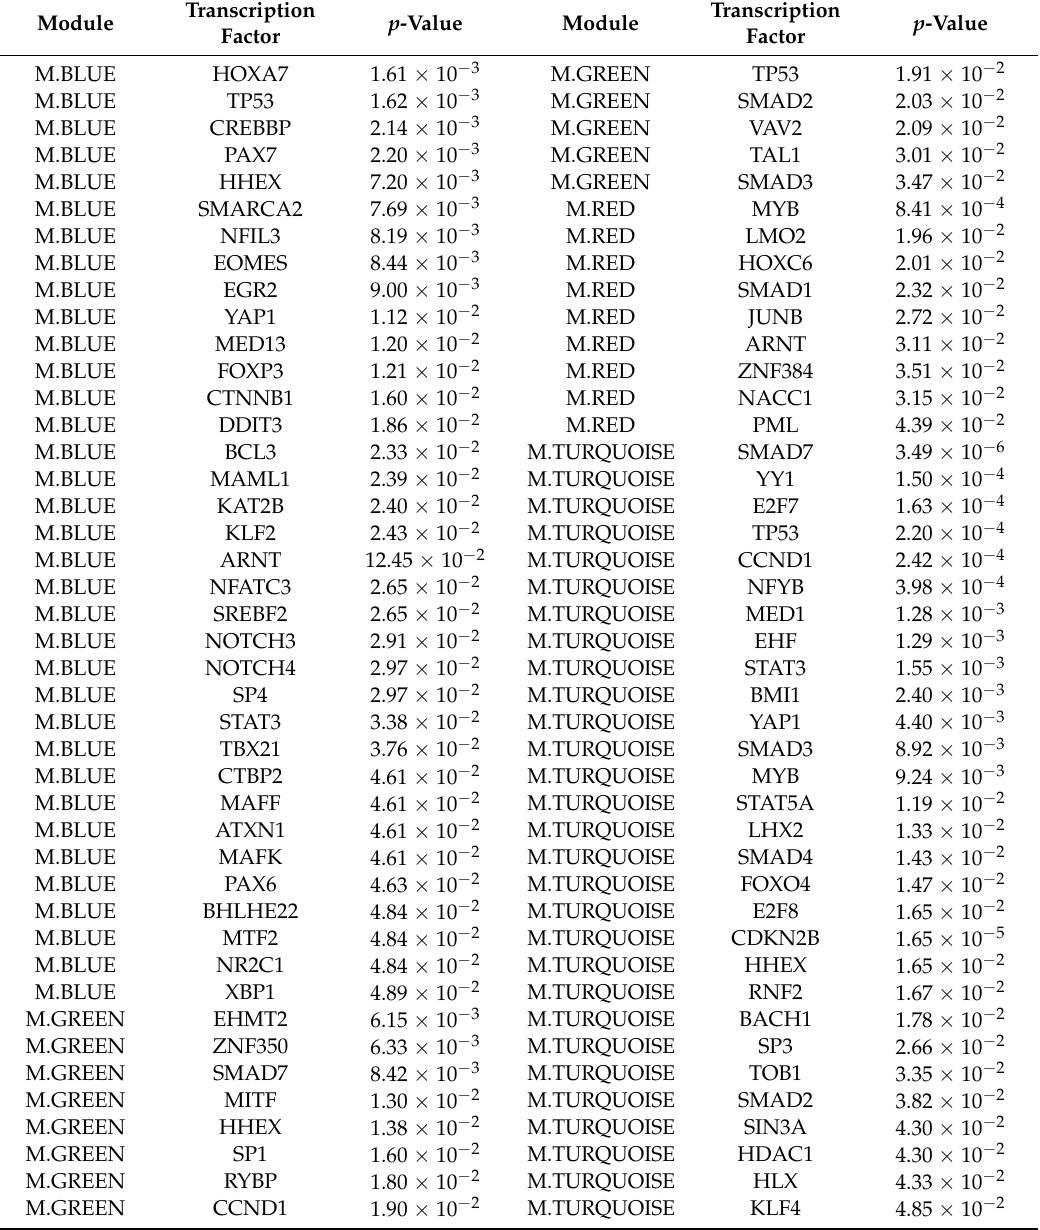
Table 6. Enriched transcription factors for target genes of miRNAs in important modules for